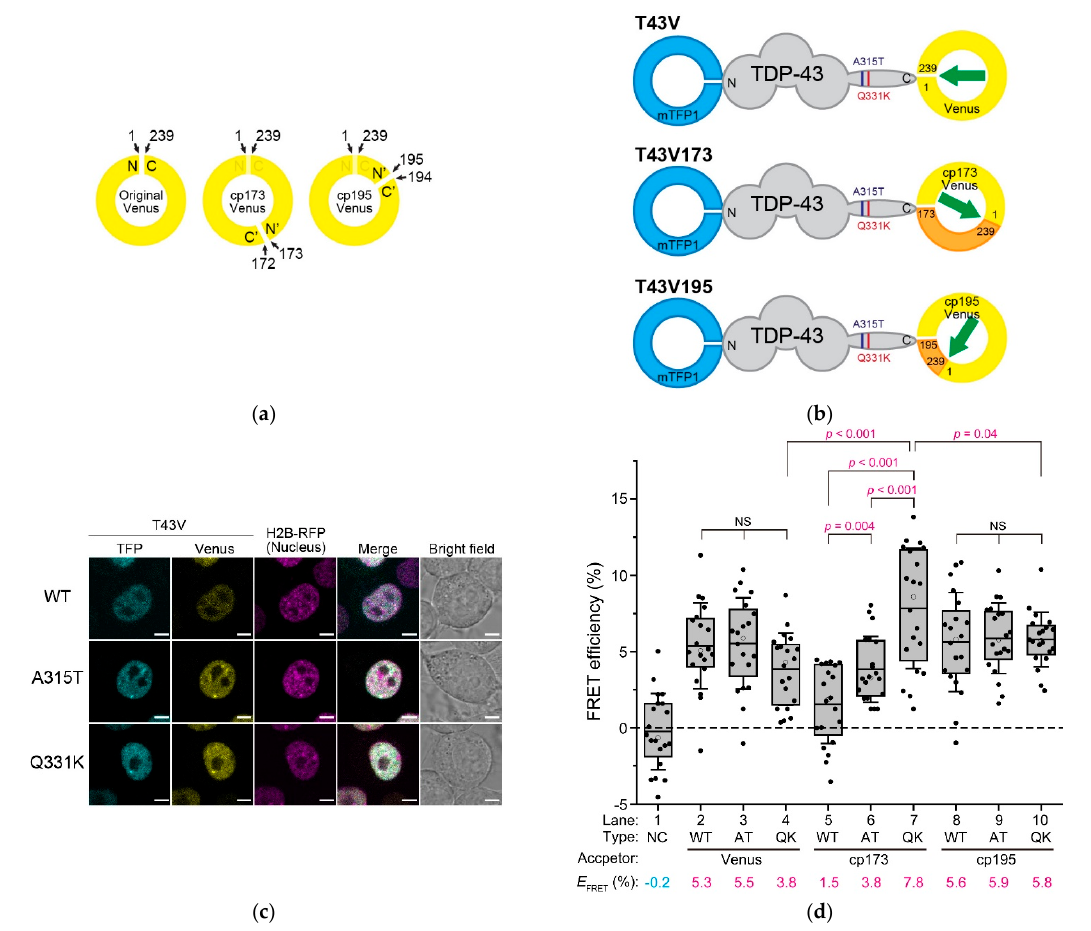
Figure 2. FRET efficiency of fluorescently labeled TDP-43. ( a ) schematic diagram of the circular permutation of an Aequorea victoria -derived fluorescent protein such as Venus. N and C denote the N- and C-termini of the original Venus. N’ and C’ denote the newly emerged N- and C-termini of the circularly permutated Venus (cp173Venus and cp195Venus). The numerical values and arrows indicate the positions of the amino acids; ( b ) schematic primary structures of the Clavularia -derived monomeric teal fluorescent protein (mTFP1)- and conventional or circularly permutated Venus- tagged TDP-43 (T43V, T43V173, and T43V195). V173 and V195 indicate the circularly permutated Venus (cp173Venus and cp195Venus, respectively). N and C denote the N- and C-termini of TDP-43. The positions of the ALS-associated mutations (A315T and Q331K) are denoted by purple and deep red color lines in the TDP-43 structure, respectively. N/C and the numbers in the illustration of Venus indicate the same as in ( a ). The green arrows indicate the schematic dipole moment of Venus; ( c ) confocal fluorescence images of the Neuro2A cells expressing T43V and Histon H2B-RFP as a nuclear marker. WT, A315T, and Q331K denote the wild-type and ALS-associated mutants of TDP-43, respectively. Scale bar = 5 µ m; ( d ) box and dot plot of the acceptor photobleaching-based quantitative FRET efficiency of T43V in the live Neuro2a cells. The dots indicate the quantitative FRET efficiency measured in individual cells. The top and bottom of the box indicate the 75 and 25 percentiles, respectively. The horizontal lines in the boxes show the mean FRET efficiency of T43V as also indicated at the bottom of the graph ( E FRET ) (The number of analyzed cells = 20). The bars attached to the boxes indicate ± SD. The white circles indicate the median. The dotted line shows a zero value of the FRET efficiency. Type denotes wild-type TDP-43 (WT) or ALS-associated mutants, A315T (AT) and Q331K (QK), in addition to the co-expression of both mTFP1 and Venus monomers as a negative control (NC). Acceptor denotes a type of circular permutation of the yellow fluorescent protein as FRET acceptors: Venus, cp173Venus (cp173), or cp195Venus (cp195). Significance based on the Student’s t -test: NS ( p ≥ 0.05); magenta color ( p <